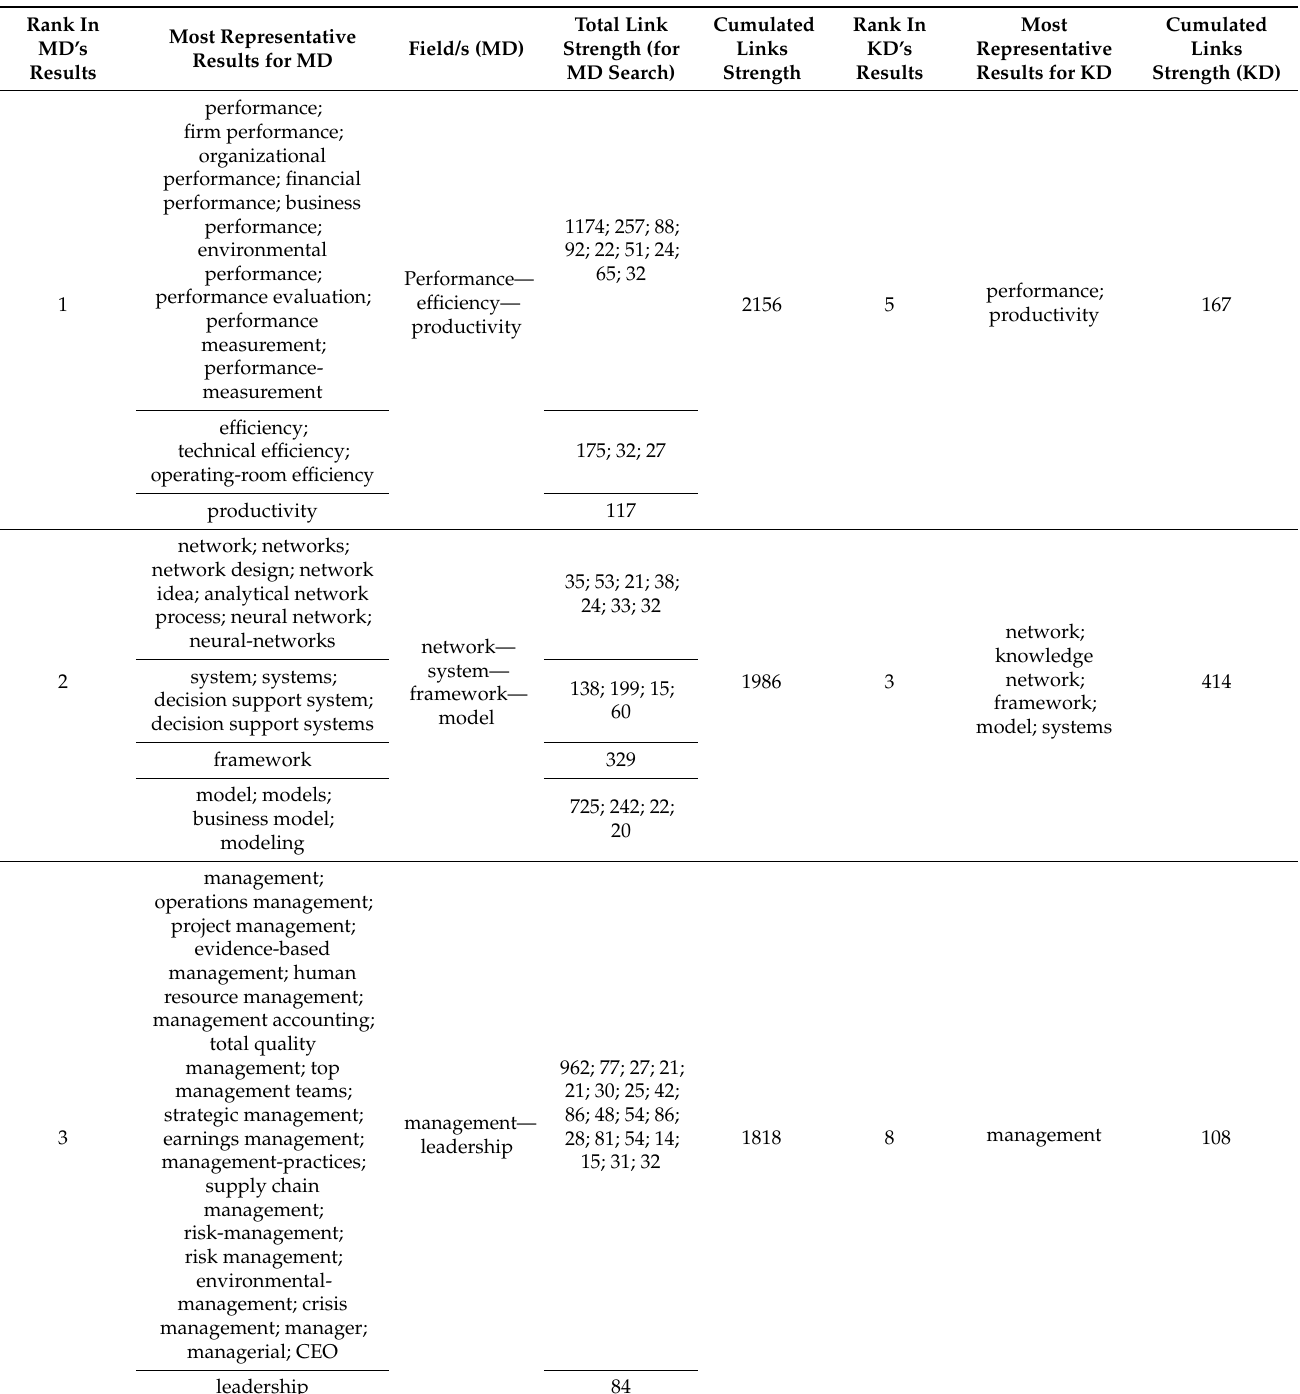
Table 8. Most relevant MD’s expressions, by VOSviewer—embedded with top items from KD’s maps (Source: authors’ own